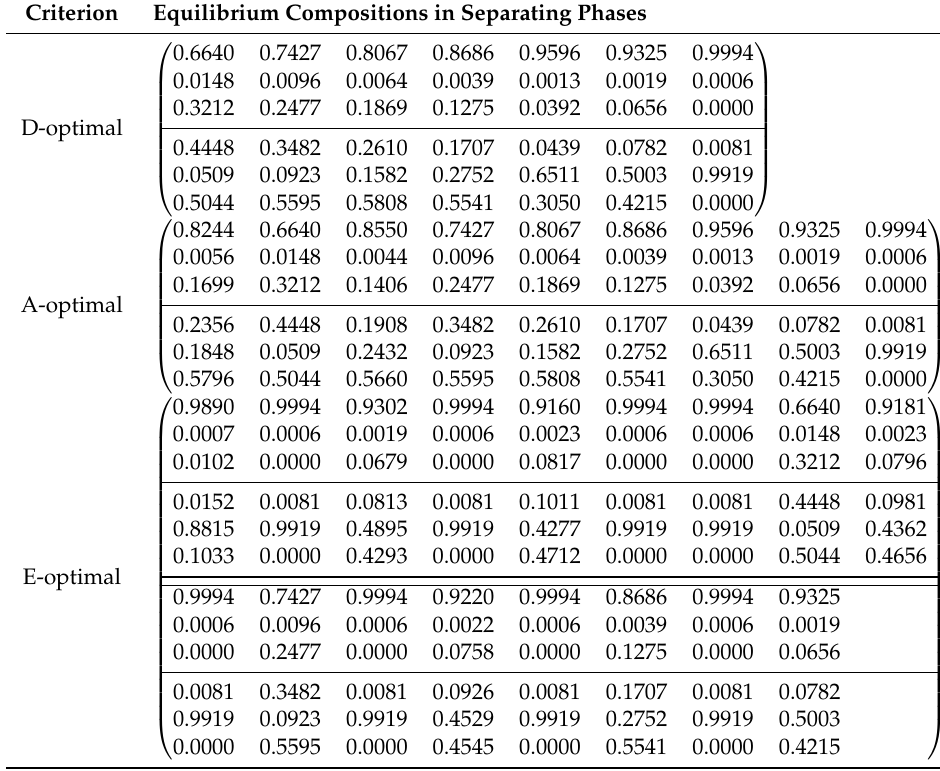
Table 6. Optimal designs for ternary system WAT-TOL-ANL and θ including nine parameters (compositions in equilibrium